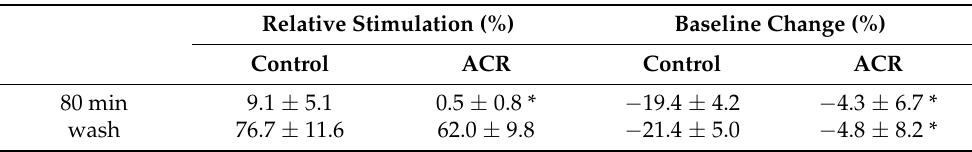
Table 3. Effect of nereistoxin (NTX) with or without ACR treatment on the isolated mouse phrenic